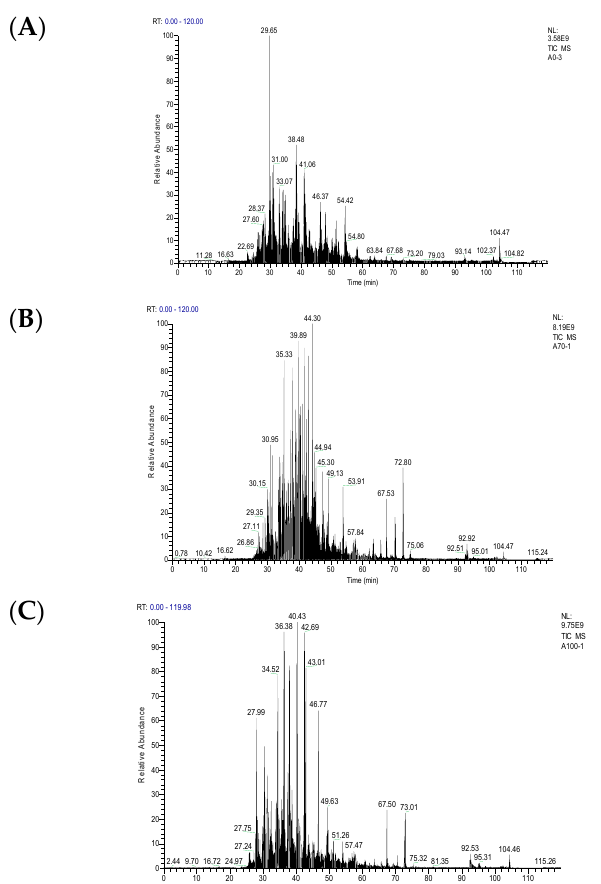
Figure 3. Representative total ion chromatogram spectra of in vitro digested products of myosin with different heating degrees (( A ): Control, ( B ): 70 °C - 30 min, ( C ): 100 °C - 30 min).